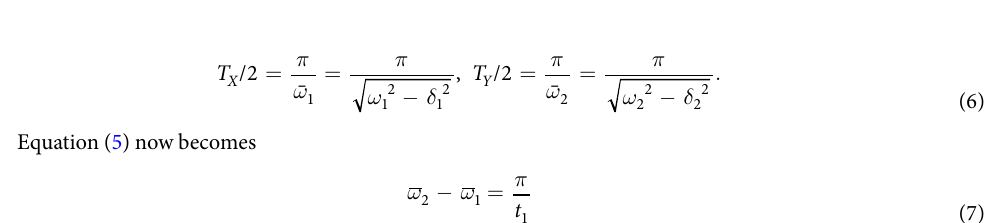
Figure 7. ( a ) Time differences between the extrema of x ( t ) and y ( t ); ( b ) Time difference versus time diagram with its zero